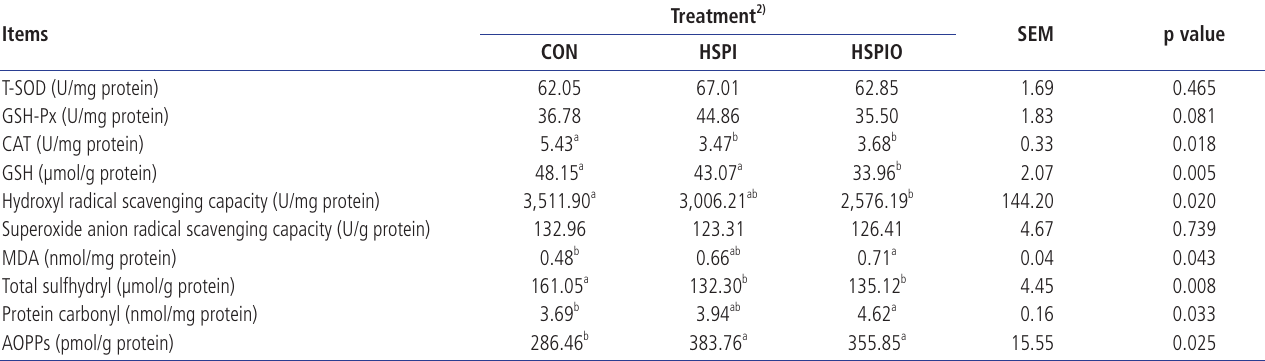
Table 6. Liver antioxidant indices and oxidation products contents of broilers fed basal diet, heat-oxidized SPI diet or heat-oxidized mixture of SPI and 2% soybean oil diet